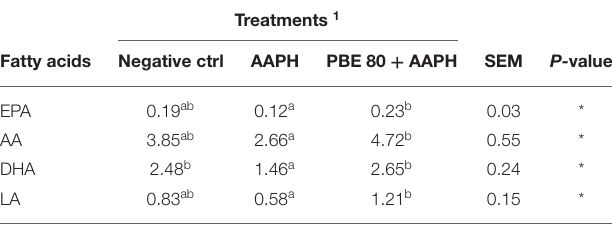
TABLE 1 | Fatty acids profile (nM) in bovine aortic endothelial cells pre-treated with pomegranate by-product extract 80 µ g/ml after 6h of 5mM AAPH exposure. Treatments